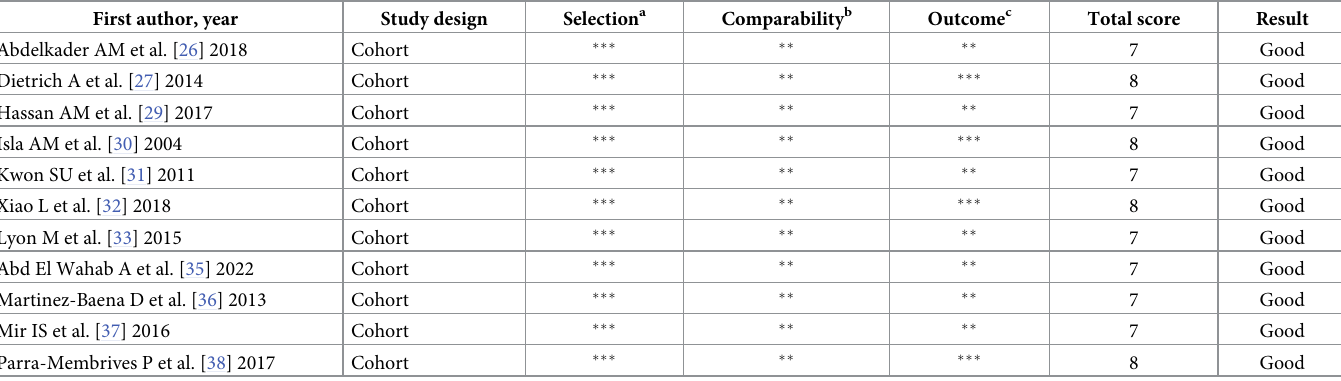
Table 2. Newcastle-Ottawa quality assessment of observational studies.